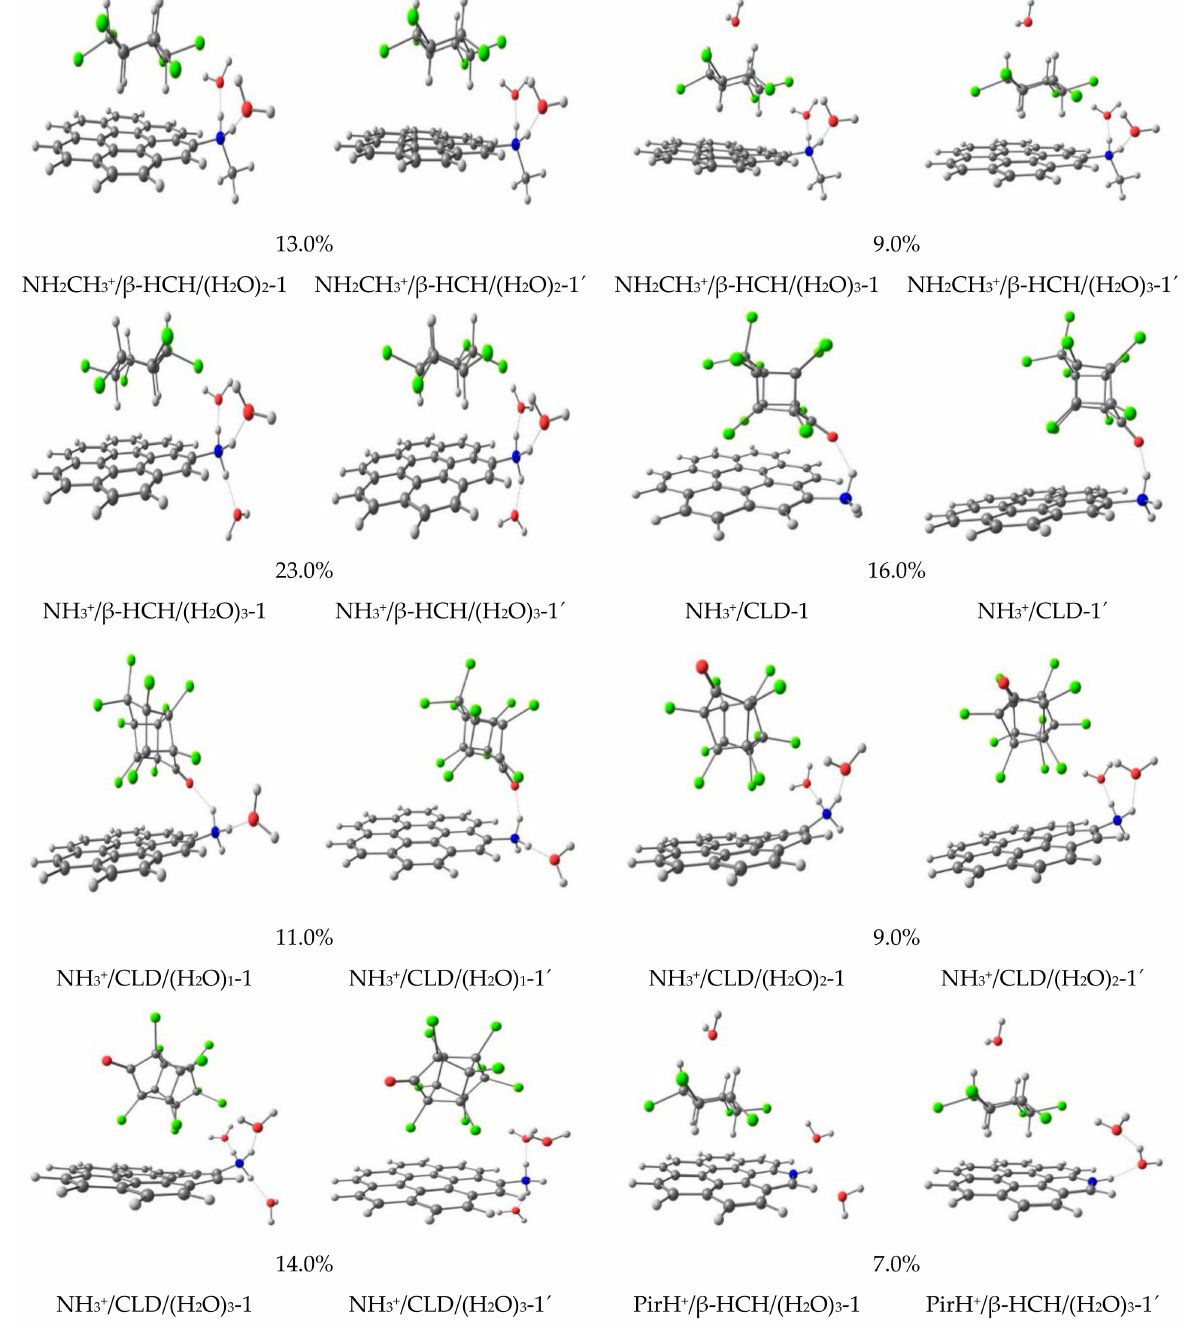
Figure 5. Distinctive minima structures and their population (%) underacidic pH conditions. Numbers denote the most stable structures found at MMH-PM7 calculations, while quoted numbers account for the corresponding reoptimized structures at the MO6-2X/6-31+G(d,p) level of